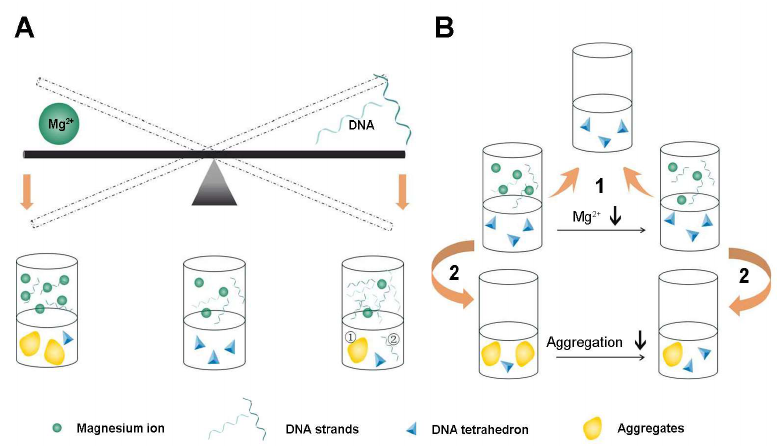
Figure 7. Illustrative diagram demonstrating the influence of different concentrations of Mg 2+ and DNA on the processes of preparation, freezing-thawing and lyophilization of Td. ( A ) The balance between concentrations of Mg 2+ and DNA strands when preparing Td. There is an appropriate range of Mg 2+ concentrations for the successful assembly of Td. A higher concentration of Mg 2+ (>10 mM) results in an apparent aggregation of the DNA, while a lower concentration of Mg 2+ (<2 mM) leads to an insufficient assembly of Td. Similarly, if the concentration of DNA reaches the upper limit (20 μM), pronounced aggregation also makes the assembly fail. Therefore, successful self-assembly of the Td can only be achieved by maintaining the balance of the two ingredients. ( B ) Freeze-thawing has no influence on the structure of the formed Td (1), but lyophilization increases the risks of Td aggregation, which would be largely attenuated by reducing the concentration of Mg 2+ in the initial prepared buffer (2).